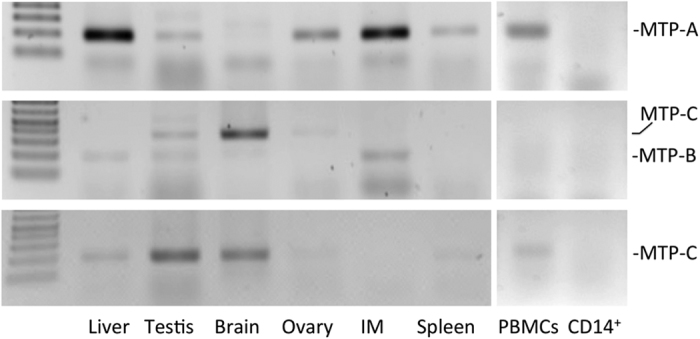
Expression of MTP splice variants in human tissues.MTP-A mRNA is robustly expressed in liver and intestinal mucosa (IM), but it is also found in testis, ovary, and spleen as well as in PBMCs. It is important to note that the product from the MTP-A primer set derives from both MTP-A and MTP-C transcripts. MTP-B mRNA was detected in liver, testis and intestinal mucosa. MTP-C specific primers revealed that MTP-C mRNA is expressed in liver, testis, brain, ovary, spleen, and PBMCs. (Note: primers for MTP-B also detect MTP-C.)